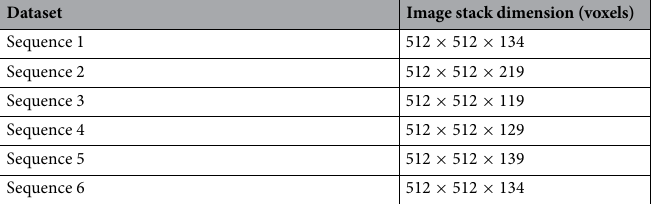
Table 3. Multi layer pavement cell dataset 23 . It contains three layers of cell walls in the shoot apical meristem of A. thaliana’s that spans over 80 h with with a xy-resolution of 0.22 μm and 0.26 μm thick optical sections. The time step is 4 h for all sequences and each sequence has 20 frames. Cells with track IDs are fully provided.